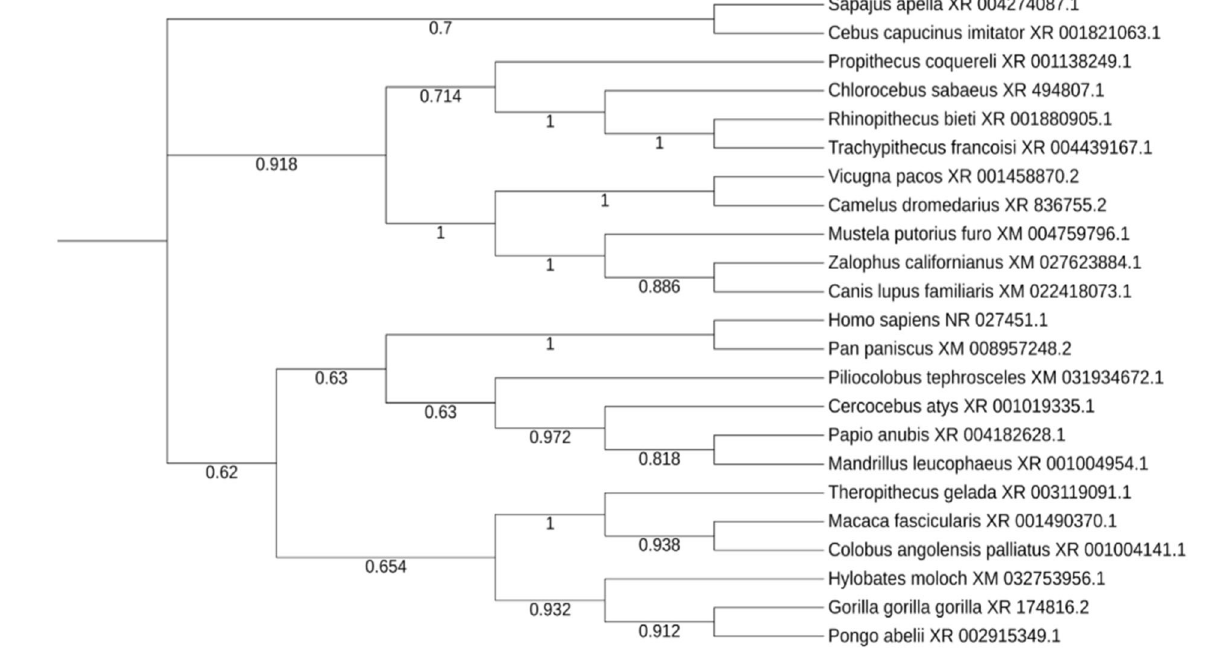
FIGURE 5 | Evolutionary trace of lncRNA NORAD in 23 related species, with bootstrap values at each node.